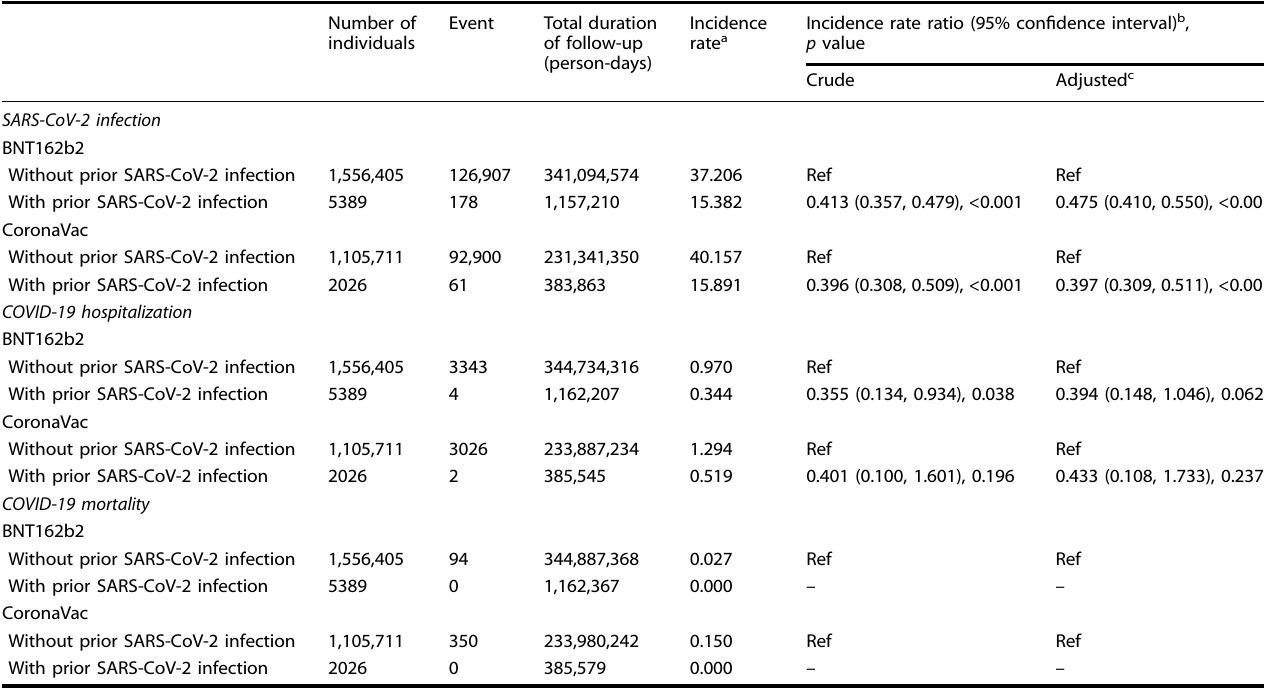
Table 2. Incidence rate ratios of study outcomes between two-dose vaccine recipients without prior infection and one-dose recipients with prior